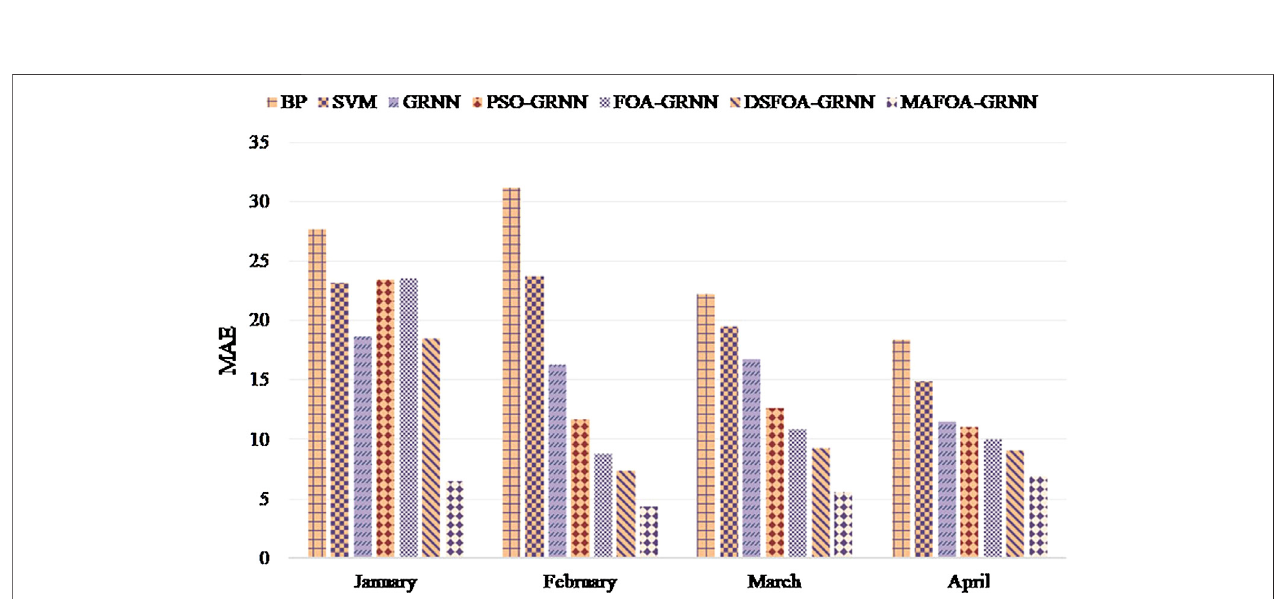
FIGURE 8 | Performance comparison of models in terms of MAE criteria.